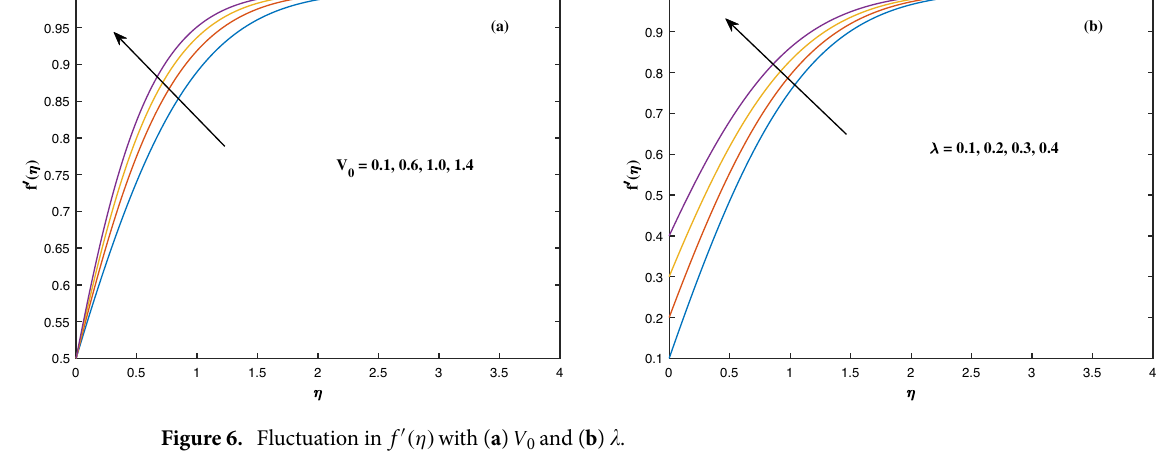
Figure 6. Fluctuation in f ′ (η) with ( a ) V 0 and ( b ) (cid:31) .